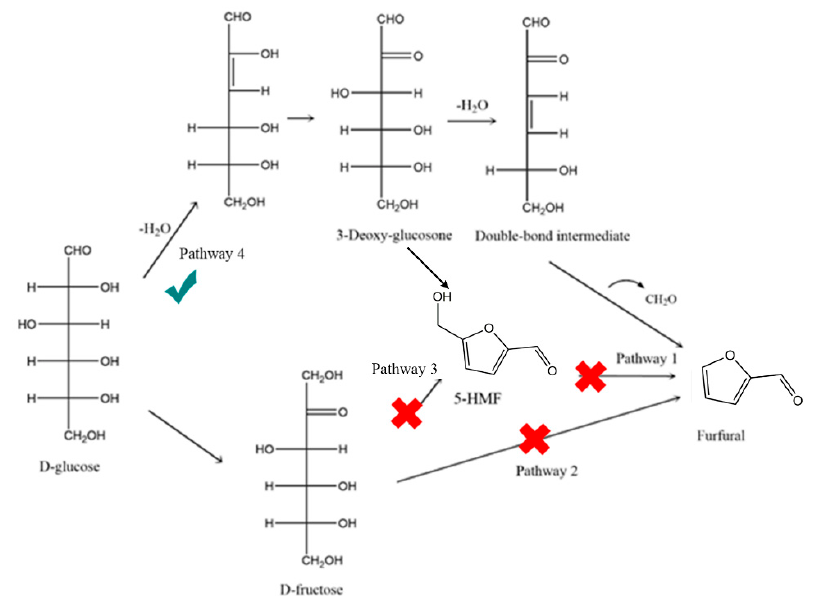
Figure 3. Possible reaction pathway for the furfural and HMF production from glucose.